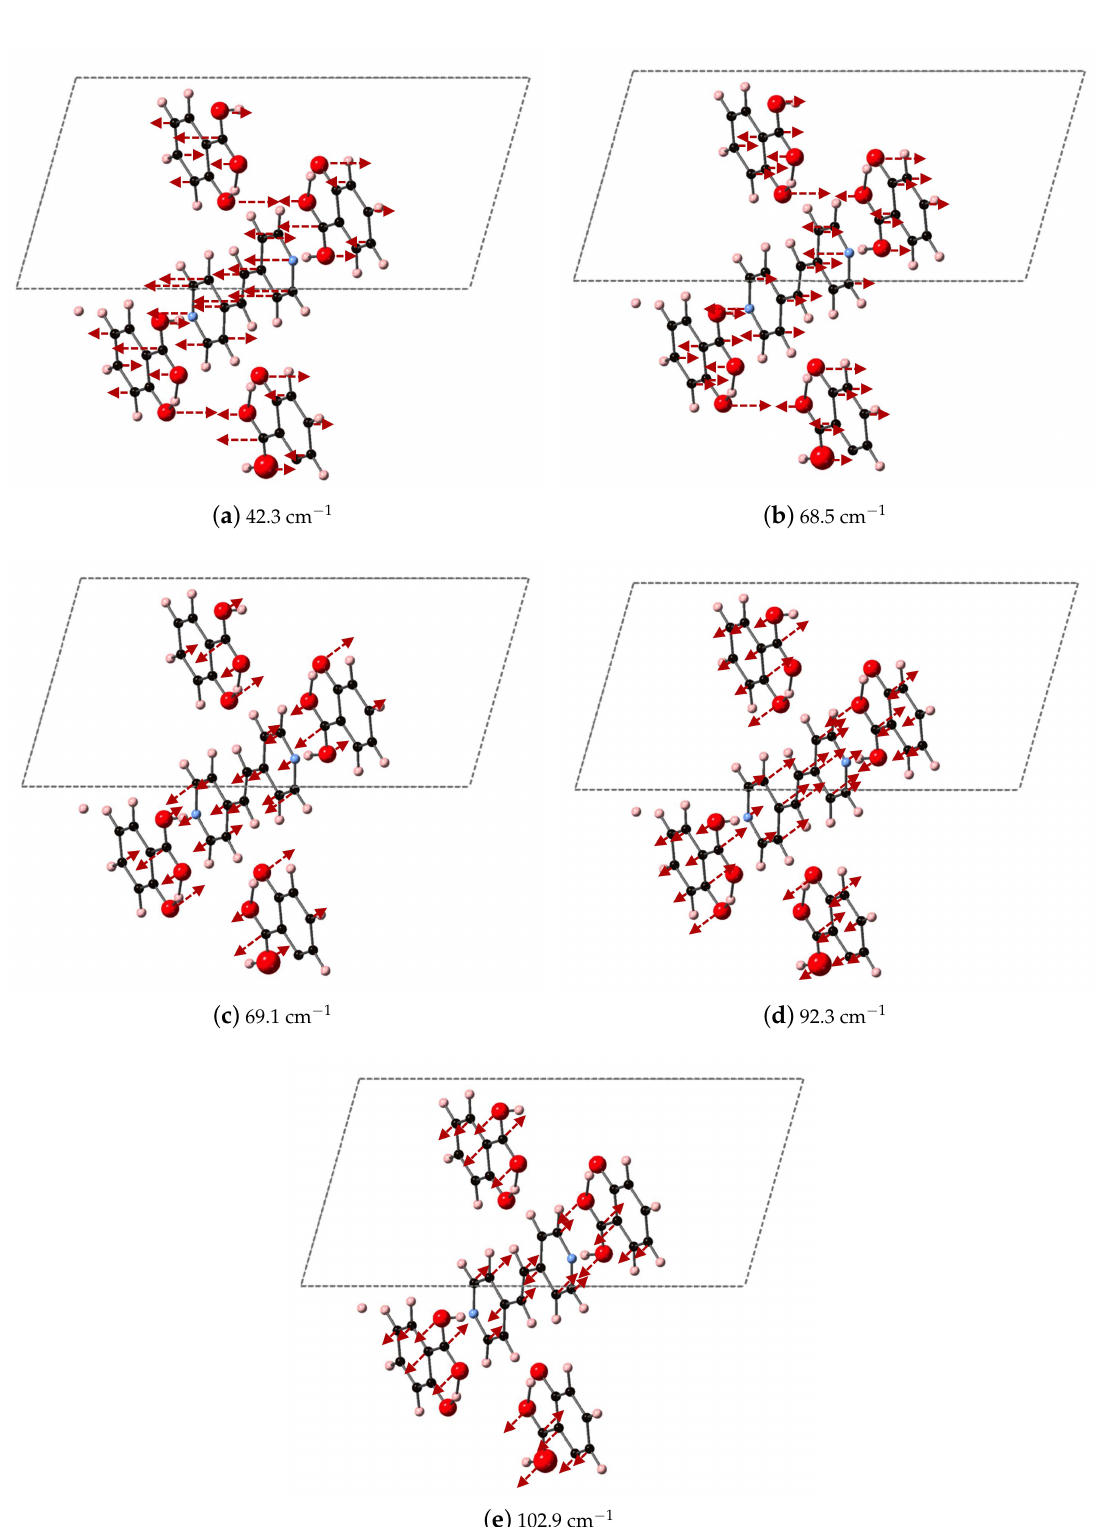
Figure 13. Depicted here are the DFT-D computed IR active modes of 2(SA) · BPE-II that occur at ( a ) 42.3 cm − 1 (along xz ); ( b ) 68.5 cm − 1 (along z ); ( c ) 69.1 cm − 1 (along y ); ( d ) 92.3 cm − 1 (along xz ); and ( e ) 102.9 cm − 1 (along xz